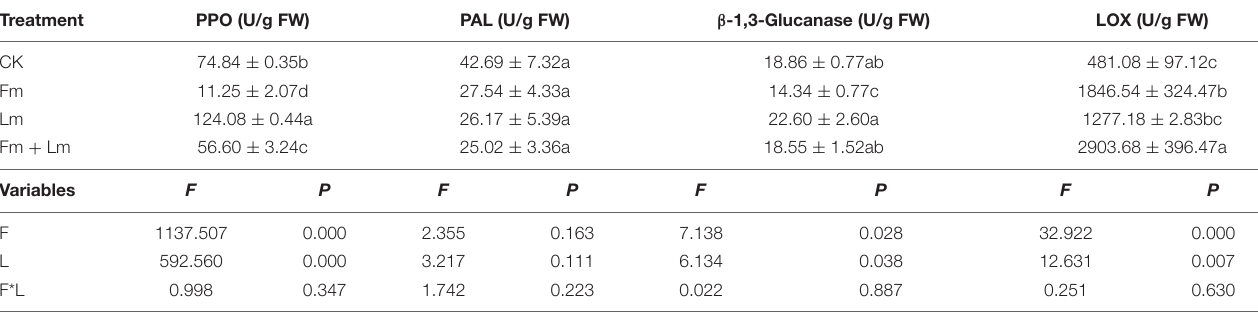
TABLE 1 | The activity of four defense-related enzymes in leaves of Elymus nutans plants in response to mycorrhizal colonization by F. mosseae and herbivorous feeding by fifth-instar grasshoppers L. migratoria .